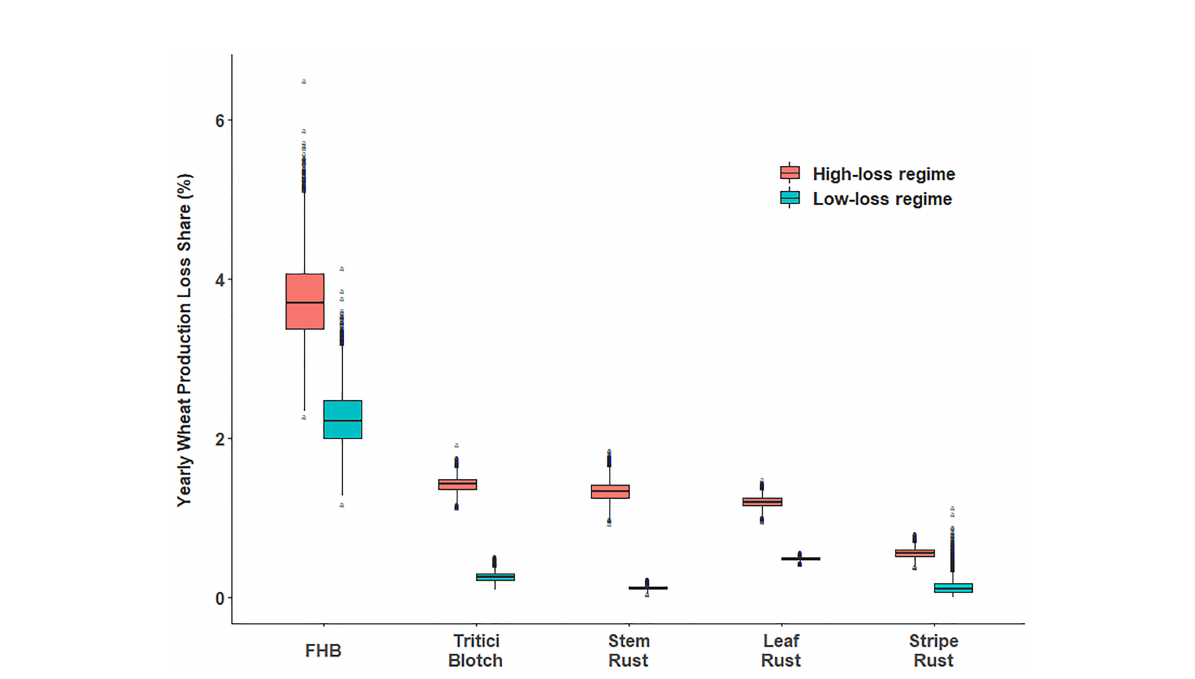
FIGURE 3 Distribution of simulated global yearly wheat production loss percentage attributable to selected wheat fungal diseases. Note: For the box plot, the lower and upper hinges correspond to the fi rst and third quartiles (the 25th and 75th percentiles) with the middle line corresponds to the median from the distribution of yield losses. The upper (lower) whiskers extend from the upper (lower) hinge to the largest (smallest) value no further than 1.5 times of the inter-quartile range (distance between the fi rst and third quartiles). Outliers are marked by black